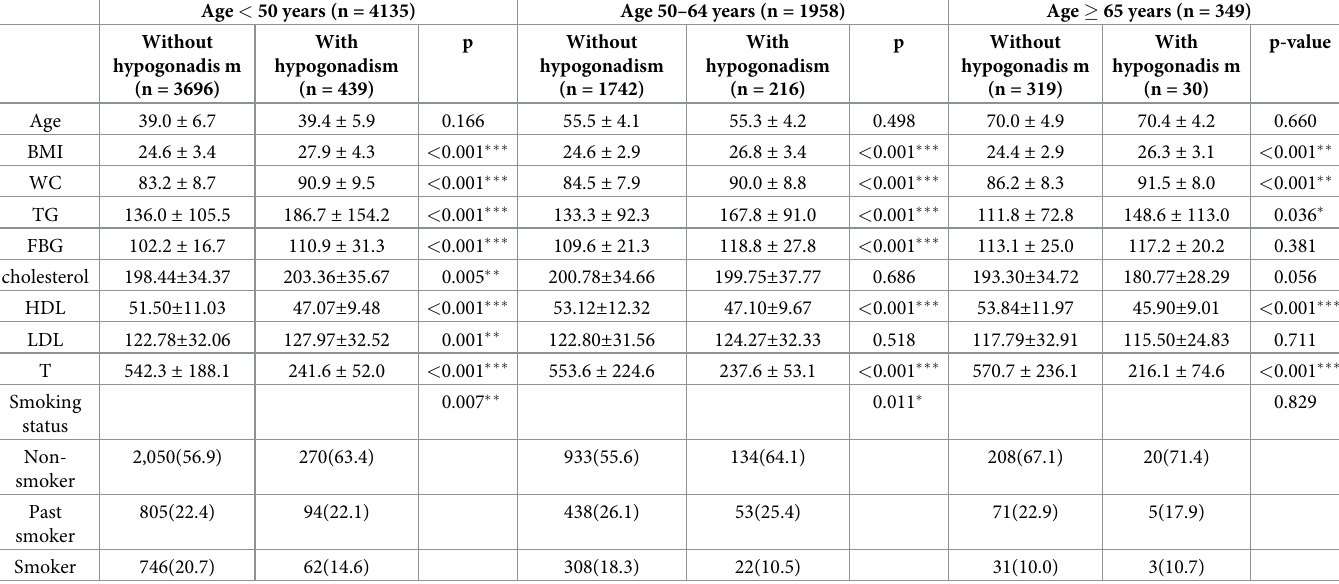
Table 1. Characteristics of participants in different age groups with and without hypogonadism.